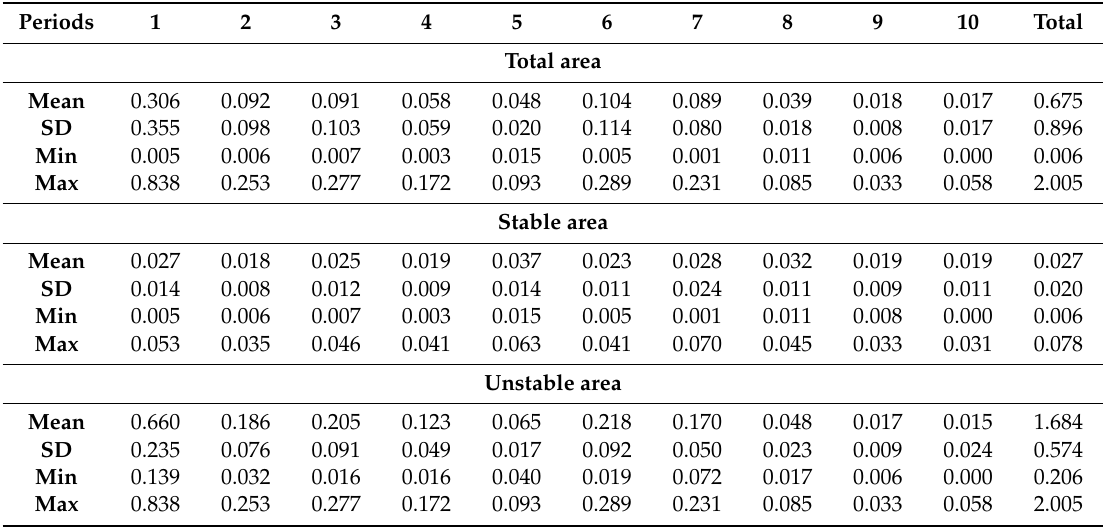
Table 4. Horizontal (XY) displacements (in m) of the monitoring points in the di ff erent periods.